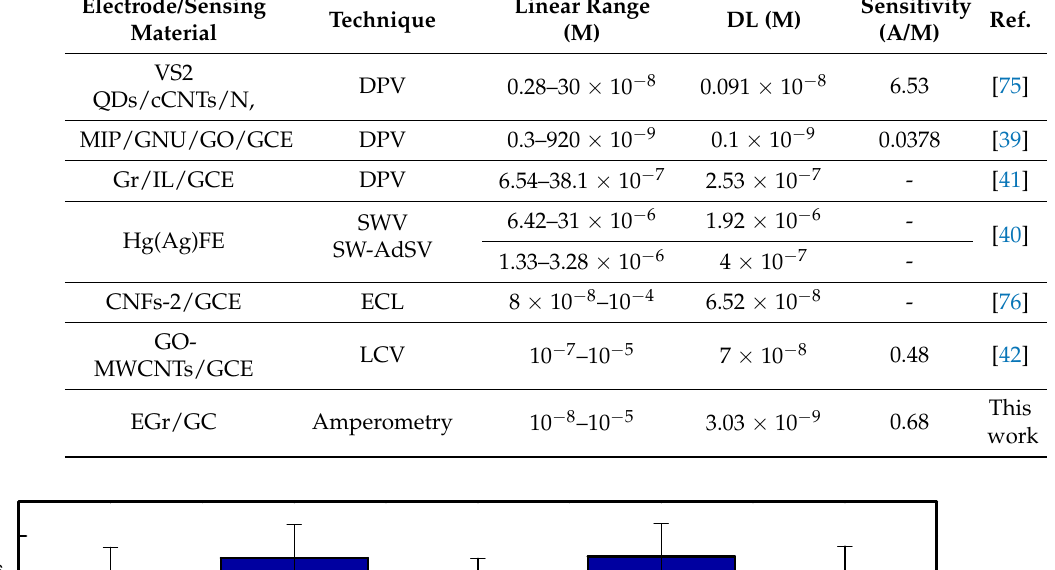
Table 1. The comparison between the electrochemical performance of EGr/GC electrode with those of other modified electrodes employed for the determination of AZT.